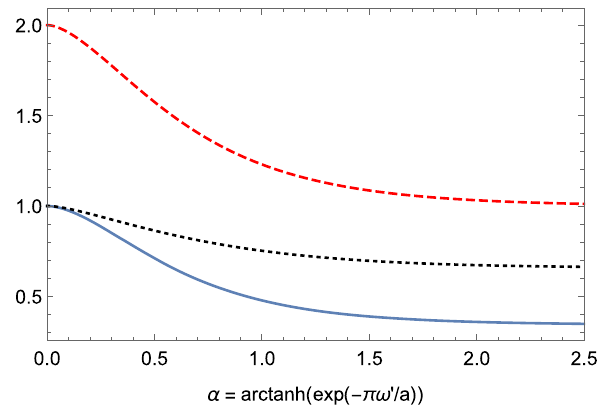
Fig. 4 State ρ M , I – Classical Correlations is the solid blue line, quan- tum discord is the black (dotted) line and mutual information is the red (dashed) line